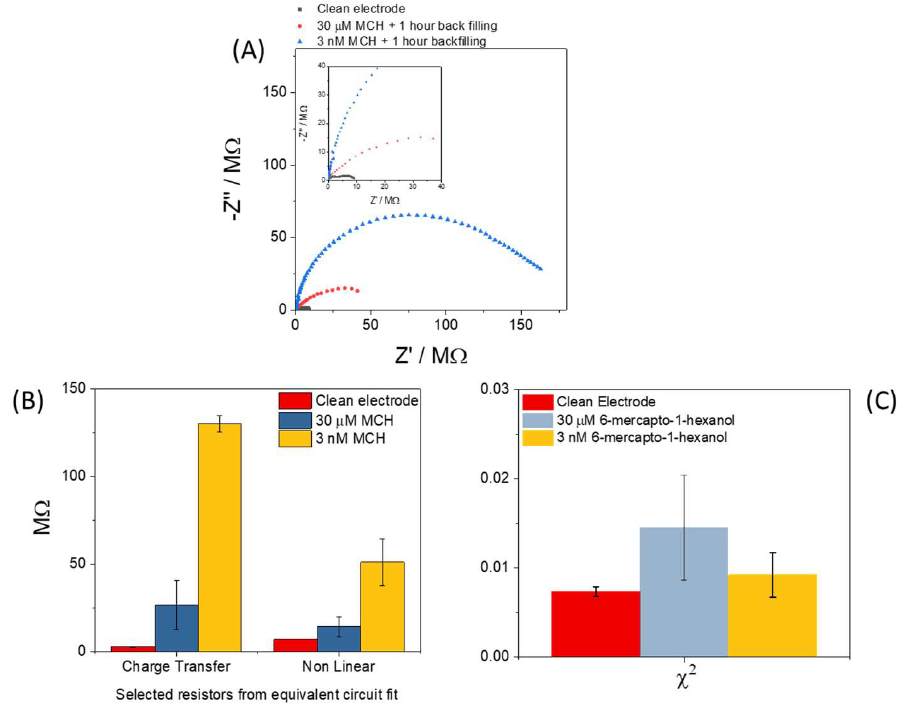
Figure 6. ( A ) EIS plots from a clean, 30 µM and 3 nM MCH functionalized microelectrode. ( B ) Fitted values for R CT and R NL on clean and functionalized electrodes prepared using both concentrations of MCH. ( C ) χ 2 ‘ goodness of fit ’ values for clean and 6-mercapto-1-hexanol solutions at 30 µM and 3 nM concentrations (N = 6 and error bars represent standard